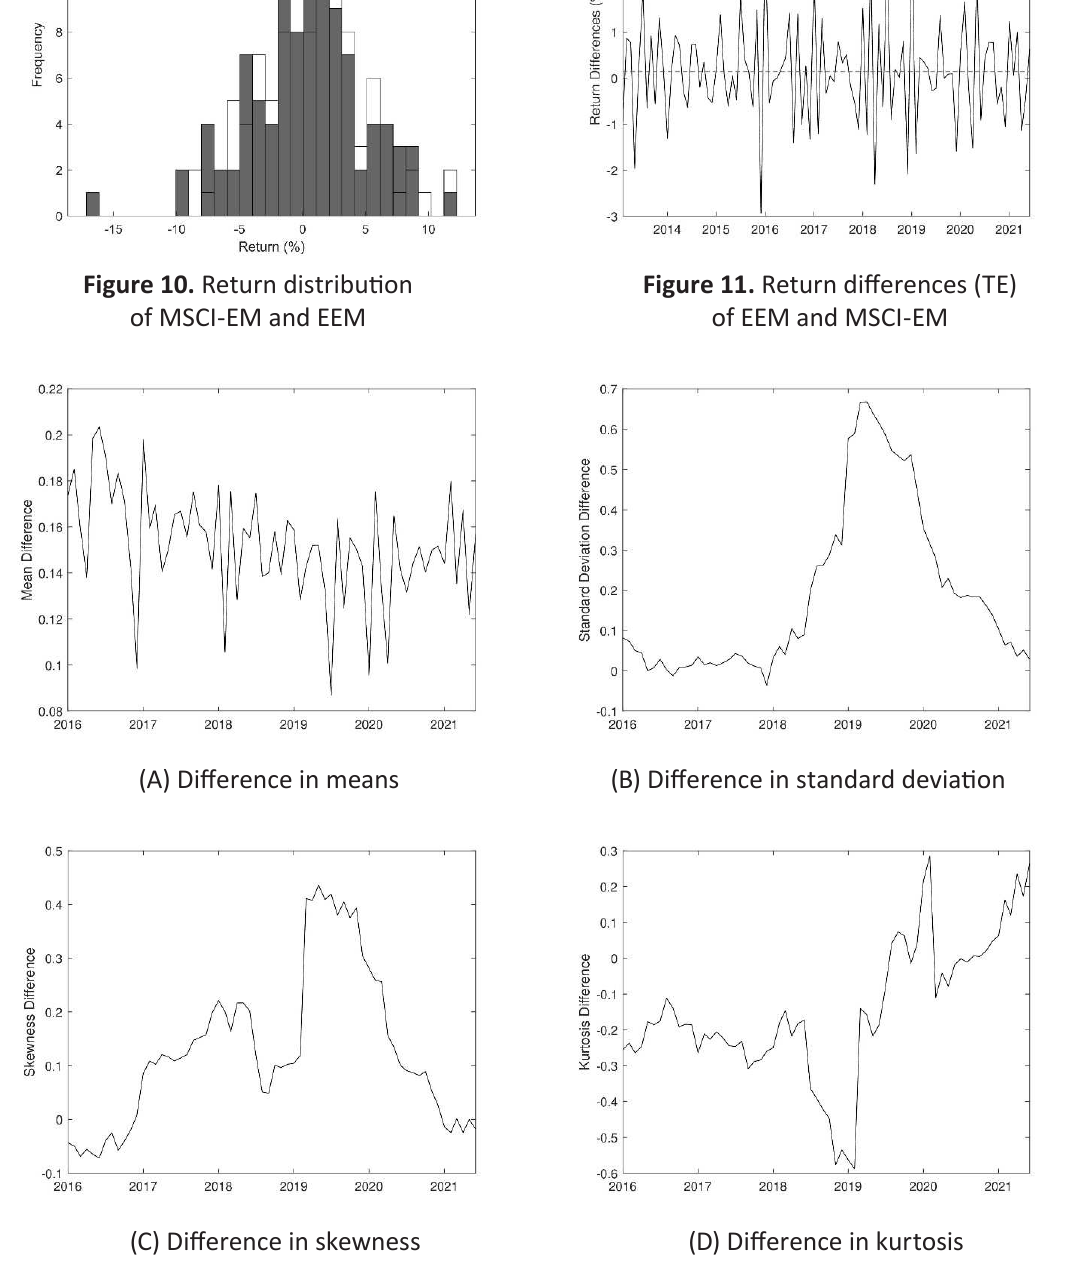
Figure 12. Difference in 3-year moments rolled through time for EEM and ences. Panel B plots the standard deviation dif- ferences. Panel C plots the skewness differences. Panel D plots the kurtosis differences. All dif-